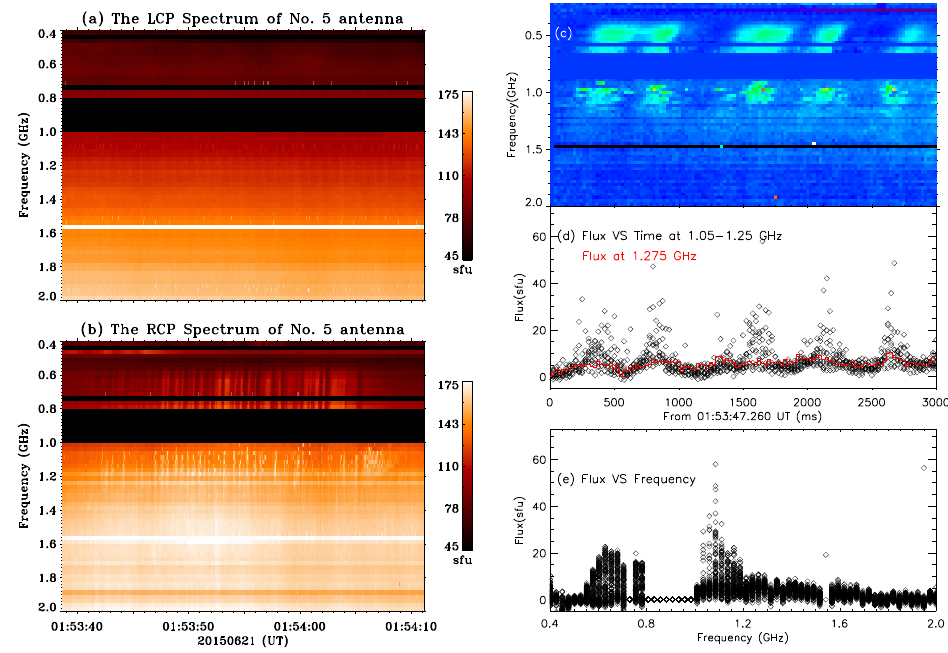
Figure 5. ( a , b ) The spectrum from 01:53:38.635 UT to 01:54:11.135 UT in LCP and RCP observed by the No.5 antenna of MUSER-I. ( c ) The zoomed-in spectral structure of QPSs from 01:53:47.260 UT. ( d ) The temporal evolution of the intensity of spikes by subtracting the continuum emission. ( e ) The frequency distribution of the intensity of spikes by subtracting the continuum